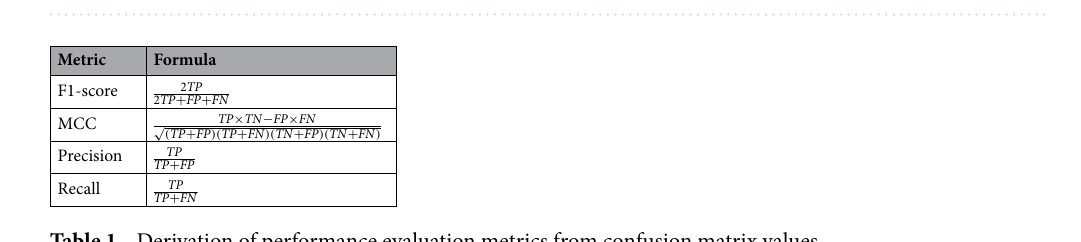
Figure 8. An overview of proposed U-Net architecture with residual blocks and deep-supervision. The complete description of all the layers in the network is available in Supplementary Figure 2.